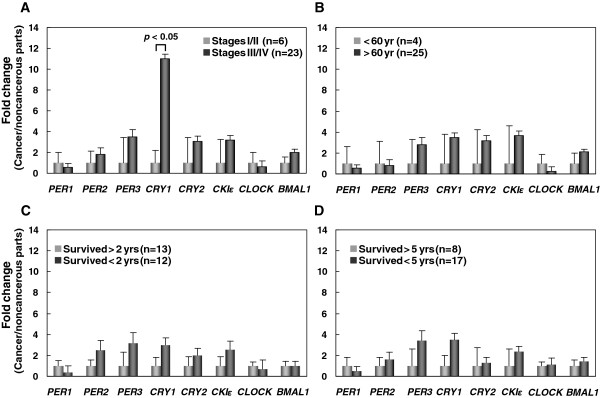
Disease severity, age, survival and circadian clock gene expression in gastric cancer (GC) patients. Disease severity (A), age (B), and survival (C, D) of 29 GC patients were correlated to the expression of eight circadian clock genes. The y-axis represents the relative messenger RNA expression level. The relative expression in cancerous tissues is calculated by ΔΔCT. The expression in stage I/II (A), age < 60 years (B) survival > 2 years (C), and survival > 5 years (D) is designated 1 and the relative expression in stage III/IV (A), age > 60 years (B), and survival < 2 years (C), and survival < 5 years (D) is calibrated to obtain the fold change, respectively. Statistical significance (p < 0.05) was evaluated with a t-test.